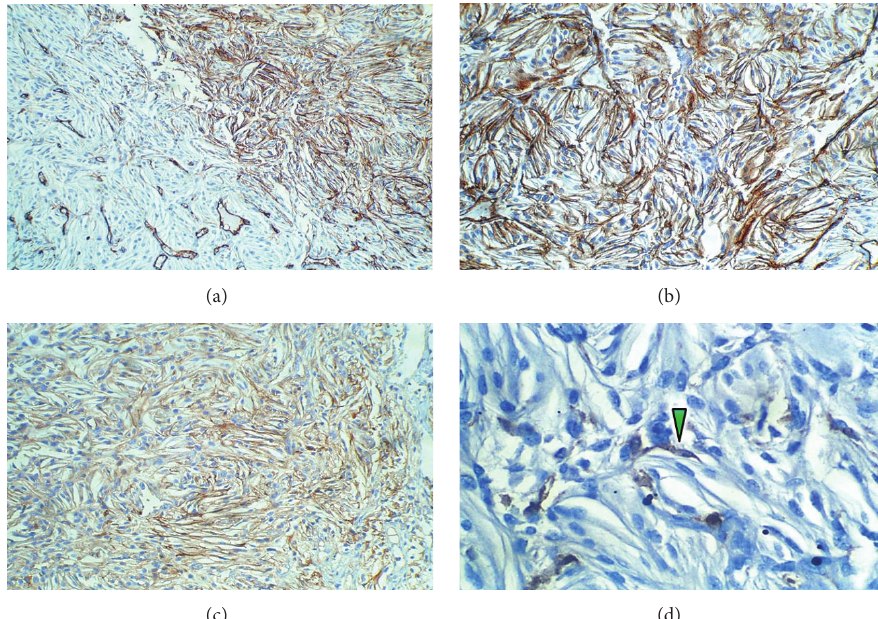
Figure 4: Extended immunohistochemistry panel. (a) CD34. Boundary zone with immunoreactive fusiform cells (right field) as well as nonreactive spindle cells (left field). Positive internal controls—endothelial cells—are identified in the latter. (b) CD34. Closer magnification of the spindle cell component carrying this antigen. (c) CD99. Expression of this marker was also confirmed. (d) FXIIIa. Immunolabeling confined to single cells (green